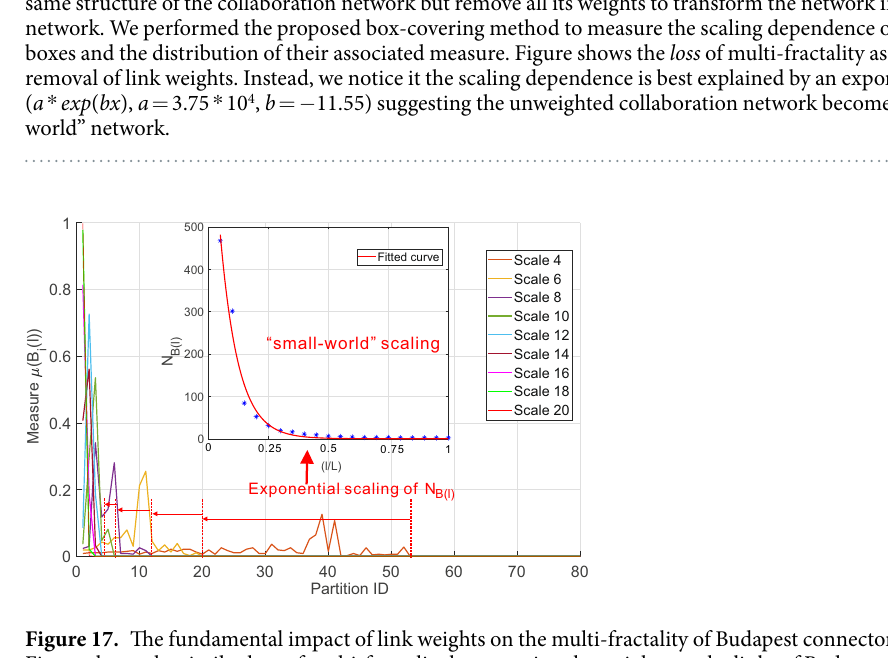
Localized scaling based network characterization and community detection. In the third set of experiments, we study how the multi-fractal analysis framework can be employed to characterize the complexity of networks beyond simply reporting whether they follow a multi-fractal/fractal scaling as many previous works did. We use the multi-scale analysis to quantify the global complexity of the network from a microscopic point of view. Based We noticed in the first two sets of experiments that a real world network is complex in the sense that there exists no common growth rule that governs the evolution of the network generation process consistently in both the scale and space domain. Similar to our two target examples when certain variation or transformation intro- duced into the network, the fundamental structural behaviors of the network are subject to remarkable muta- tions. No single model or characterization is sufficient to fully understand the structural variations and their resulting complexity of the network, hence calling for a set of expressive characterizing strategies that supplement each other to give an unbiased and well-quantified overview of the complex networks. We strongly believe that multi-fractal analysis is a powerful framework to learn the localized scaling behavior and quantify the structural variations of the complex networks. On one hand, at the microscopic level, the complexity of the network is embedded in the form of different chemical environments (i.e., the outer environment surrounding a given node) that each node interacts at different scales . More intuitively, the structural variations of the network can be understood as distinct views that a node observes with a lens of variable focal length ranging from the minimal path distance of the network up to its